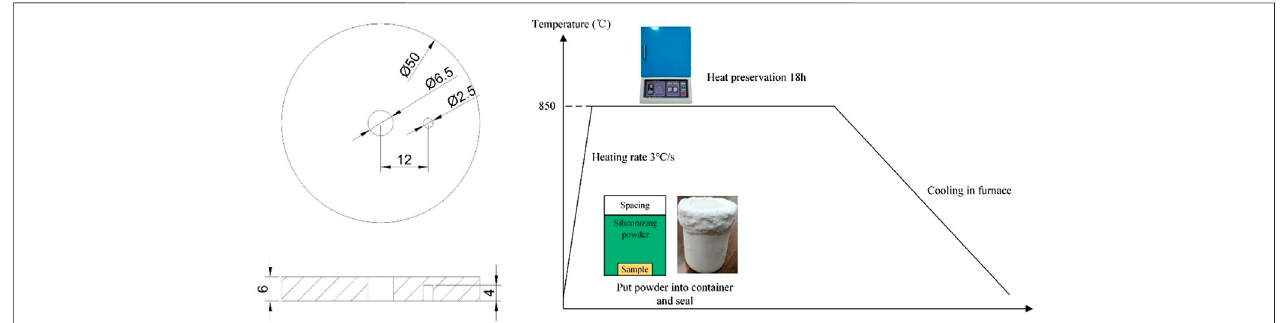
FIGURE 1 | (A) The size of aluminum bronze sample and (B) The process of pack siliconizing.